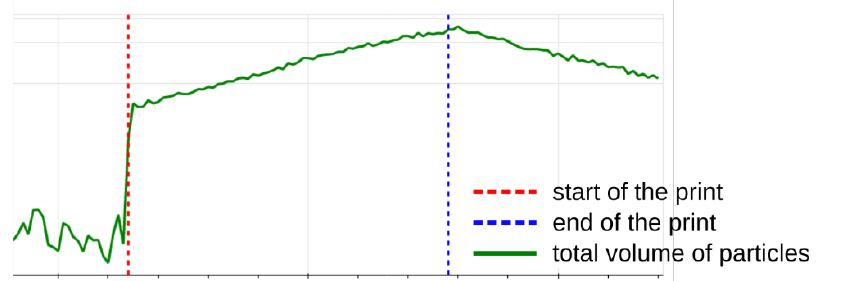
Figure 8. Prevalent progression of the process of particles volume growth during the 3D printing in an enclosed chamber.